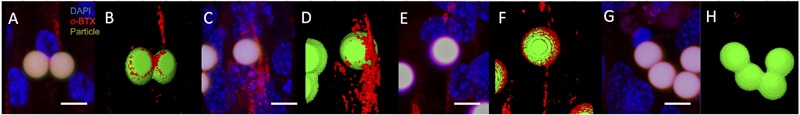
Acetylcholine receptor clustering adjacent to agrin-presenting microspheres in 2D. (A,B) After 16–24 h of presenting microspheres by suspension within culture medium, AChR clusters (red) are present in differentiated C2C12 cells cultured on fibrin and adjacent to microspheres (green) presenting surface-adsorbed agrin, even in complex cell topographies. (C,D) Similar behavior is observed after 5 days of suspension treatment in cultured cells adjacent to microsphere surfaces with covalently bound agrin. (E,F) This behavior is maintained when covalently bound agrin microspheres are embedded within the underlying fibrin gel for the entire 8-day period of culture. (G,H) Region in which cells were present but no bungarotoxin staining was observed. Negative controls (i.e., microspheres with no agrin) appeared similar to those shown in (G,H). (A,C,E,G) Represent selected rotational views of a 3D rendered confocal image stack, while (B,D,F,H) represent the same 3D renders after application of a thresholding algorithm to visually reconstruct microscopic surfaces. Images are from a randomly selected area of cells. Four separate samples were used to verify repeatability (N = 4). Scale bar represents 10 μm.